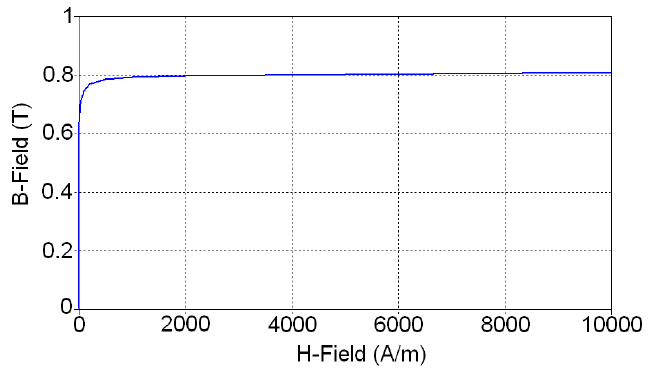
Figure 4. B-H curve of MUMETALL ®